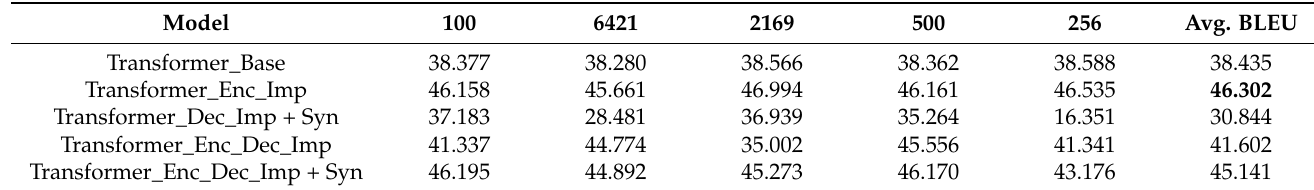
Table 3. BLEU evaluation of six-layer models on different random seeds.